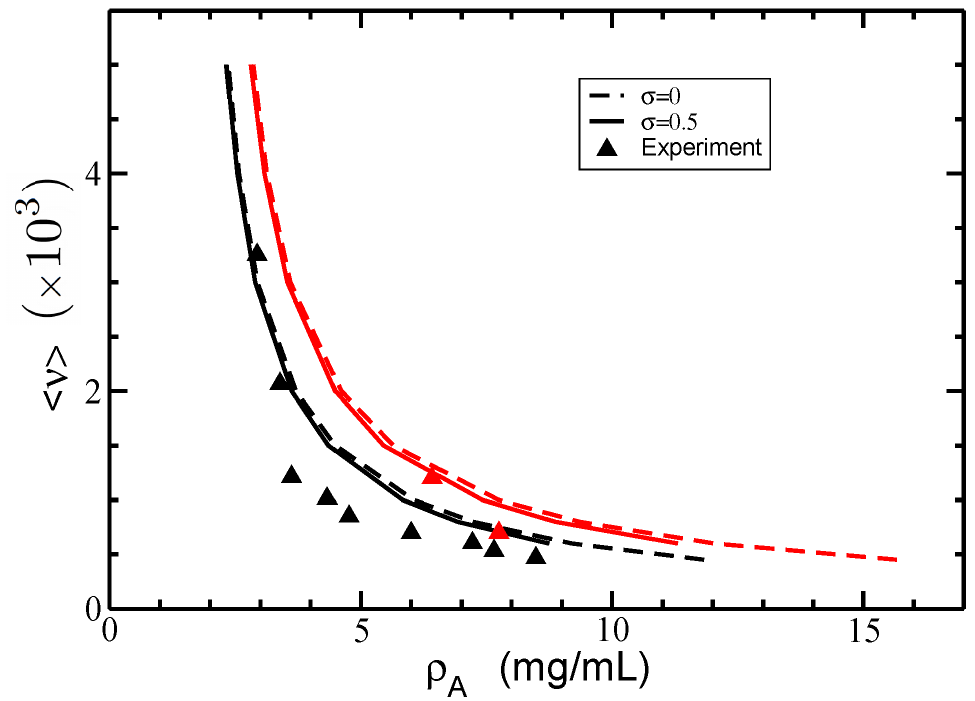
Figure 7. The isotropic–nematic phase diagram in terms of coexisting densities of actin ρ A for different average lengths of filaments < ν > and two values of the normalized standard deviations σ = 0 (dashed lines) and σ = 0.5 (solid lines). The persistence length is P = 18 µ m, and the electrolyte concentration c e = 0.1M. The experimental data (triangles) were retrieved from [26]. The coexisting isotropic and nematic densities are plotted in black and red colors,